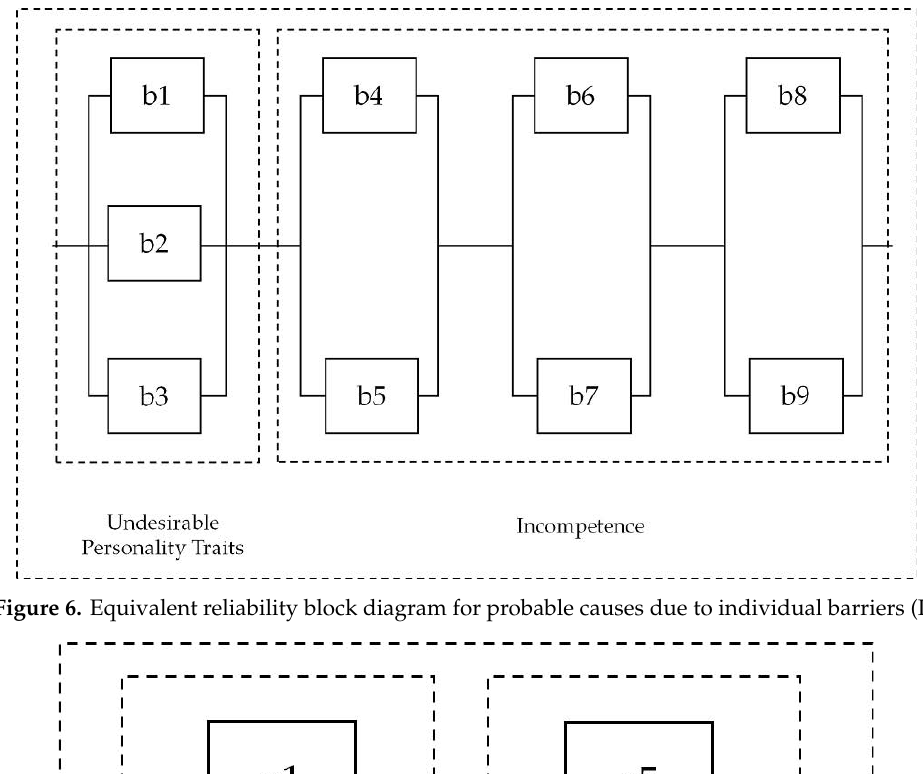
Figure 6. Equivalent reliability block diagram for probable causes due to individual barriers (I).